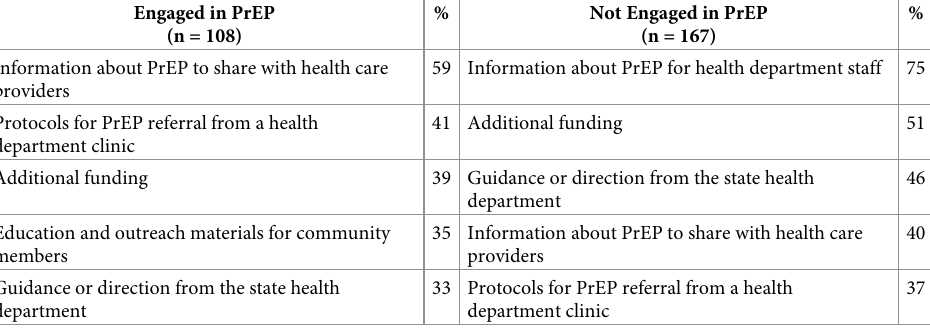
Table 5. Top five resources selected by local health departments as being most helpful for advancing or initiating PrEP implementation, United States, 2015, weighted response proportions. Engaged in PrEP % Not Engaged in PrEP % (n = 108) (n = 167)